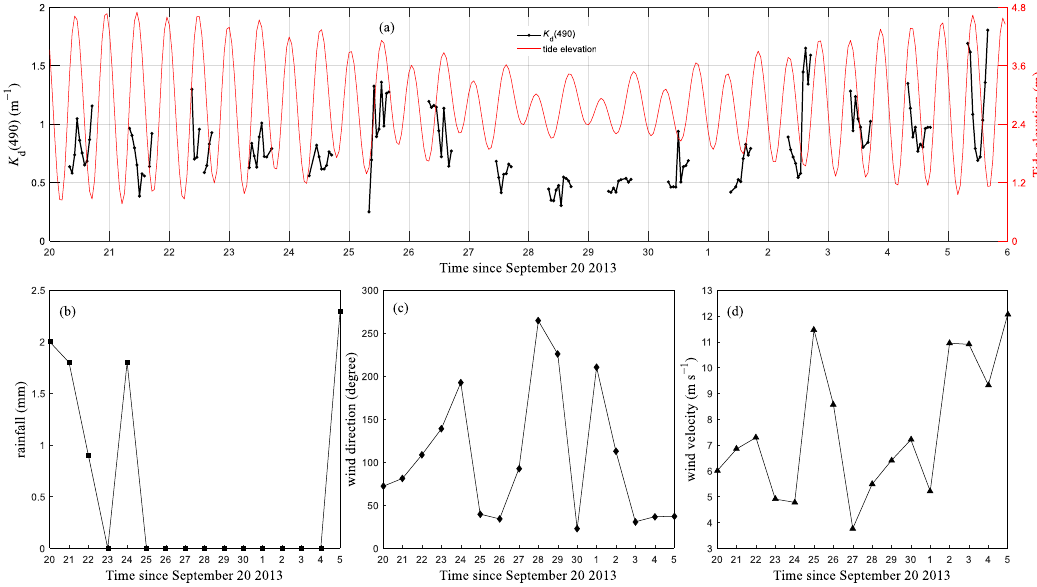
Figure 10. Diurnal variation of buoy K d ( 490 ) and the corresponding meteorological parameters in the spring–neap cycle between 20 September and 5 October, 2013. ( a ) Time series of hourly K d ( 490 ) and tide elevation. ( b – d ) Daily accumulated rainfall, daily mean wind direction, and velocity, respectively. The rainfall, wind direction, and wind velocity were calculated from data from 00:00 to 23:00